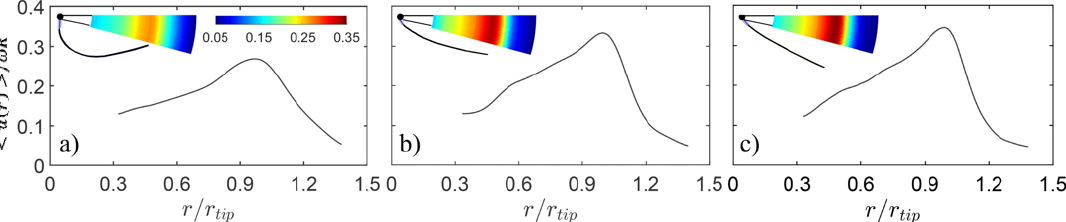
Figure 7. θ —averaged mean velocity distributions of the different plates at ω = 60 rpm: ( a ) thin; ( b ) medium; and ( c ) thick.